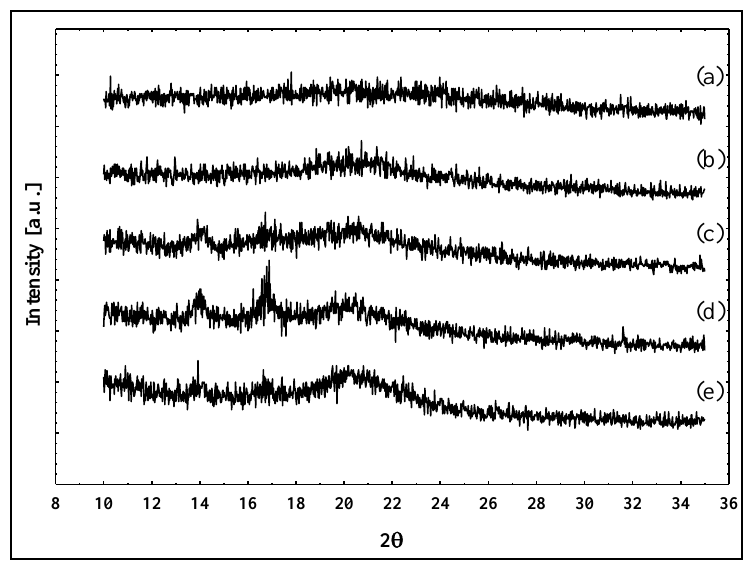
Figure 1. XRD of SF/CHI blended films with the ratio SF:CHI of (a) 100:0, (b) 75:25, (c) 50:50, (d) 25:75, (e)